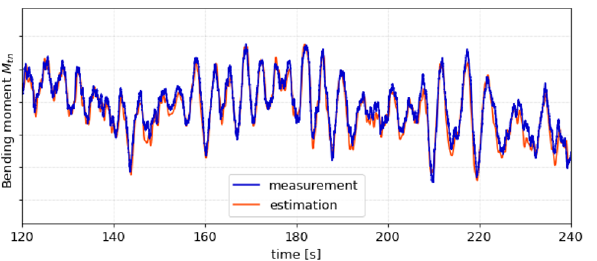
Figure 7. Bending from strain measurement and corresponding estimation in the FA direction for height = − 17 m LAT .